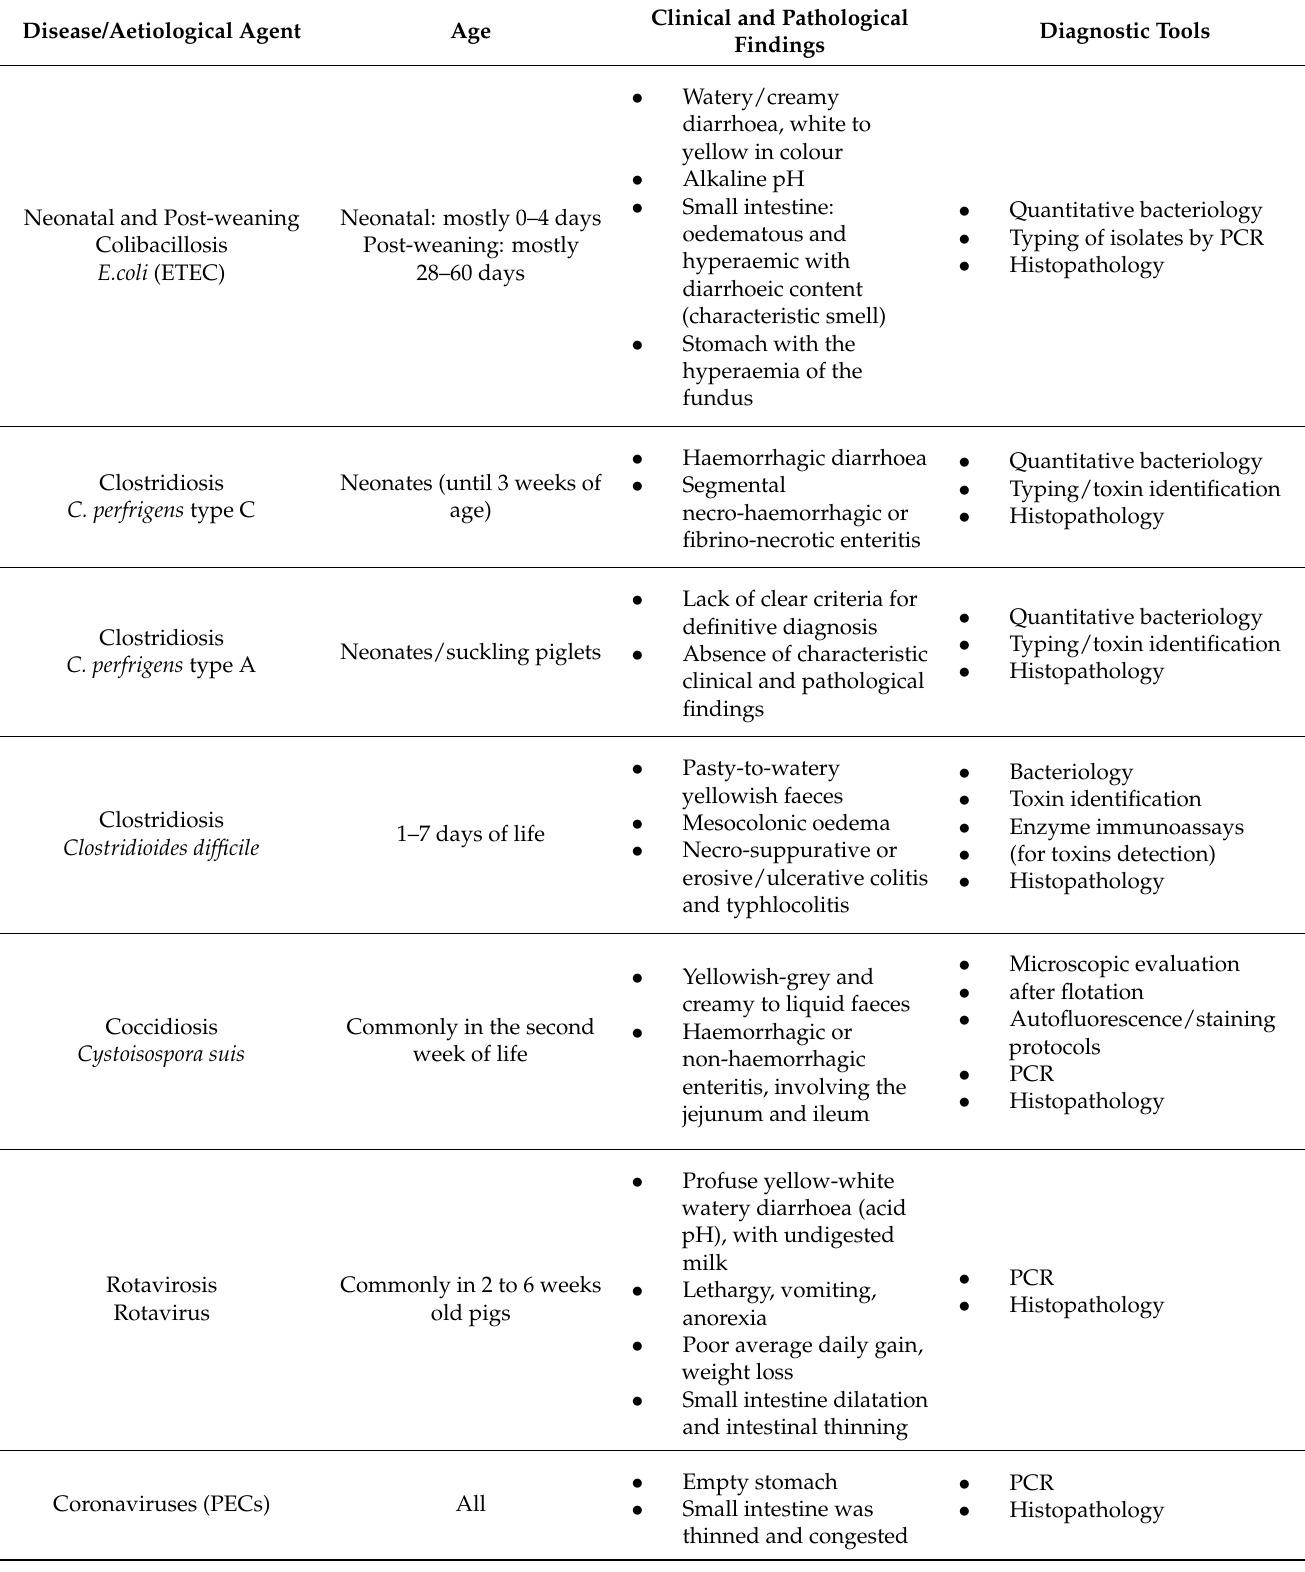
Table 3. Clinical and pathological findings and diagnostic tools of the main pig enteric